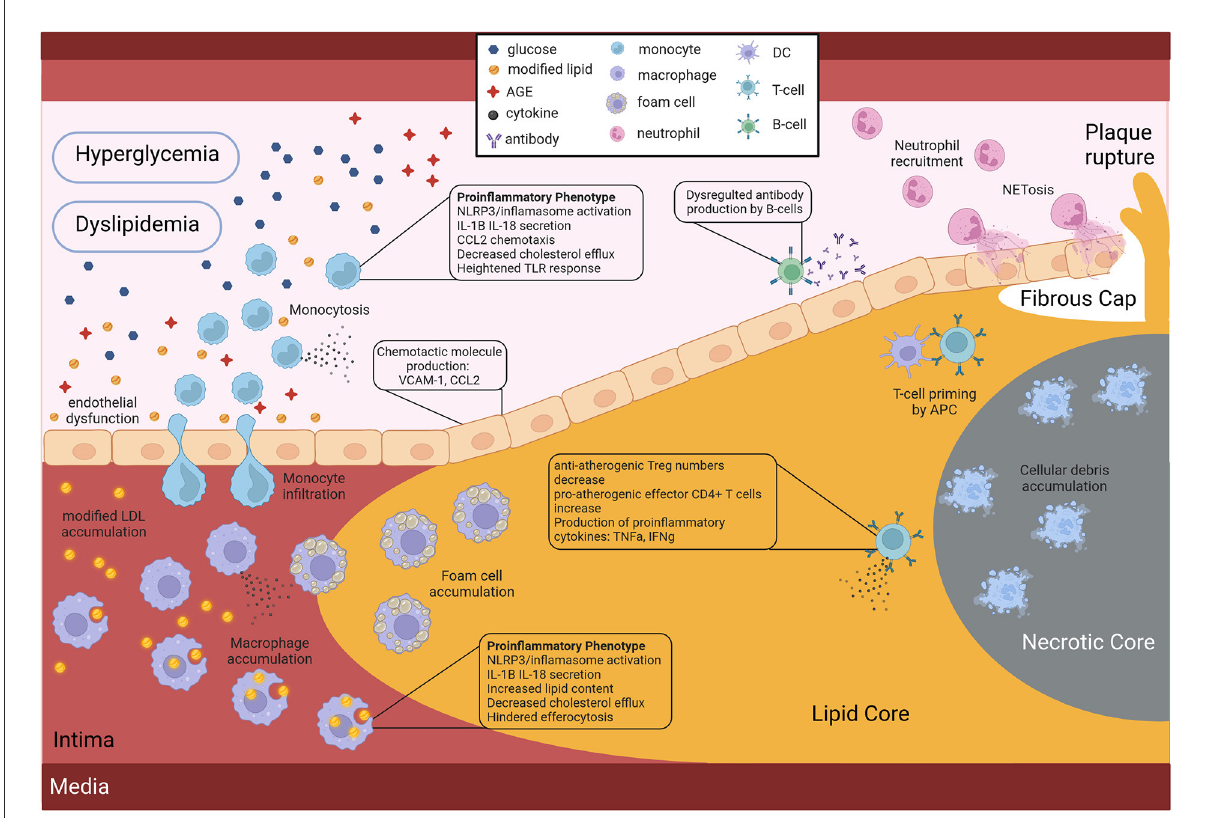
FIGURE2 Role of the diabetic environment in promoting faster and more severe atherosclerosis CV development. Hyperglycemia and dyslipidemia, two key features of DM affect the activity of both endothelial and immune cells, by inducing pro-atherogenic phenotypes. Figure created with BioRender.com online